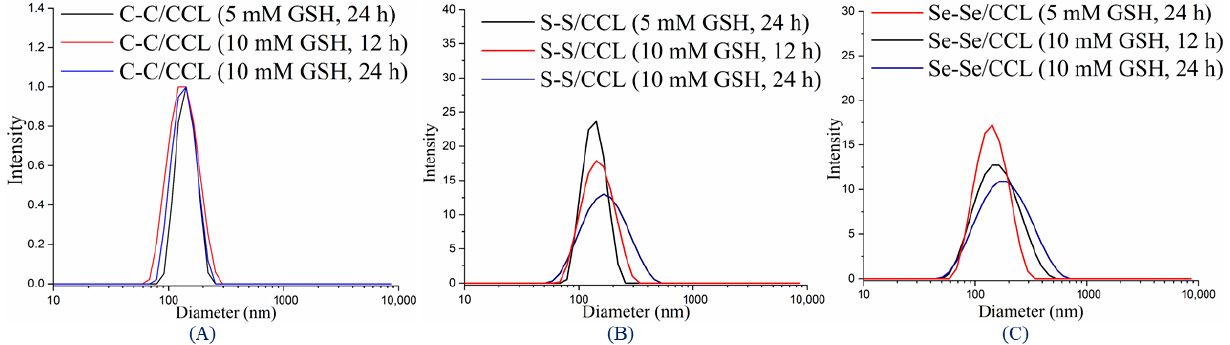
Figure 6. The size change of C–C/S–S/Se–Se CCL micelles with di ff erent GSH concentrations and treating time ( A – C ).